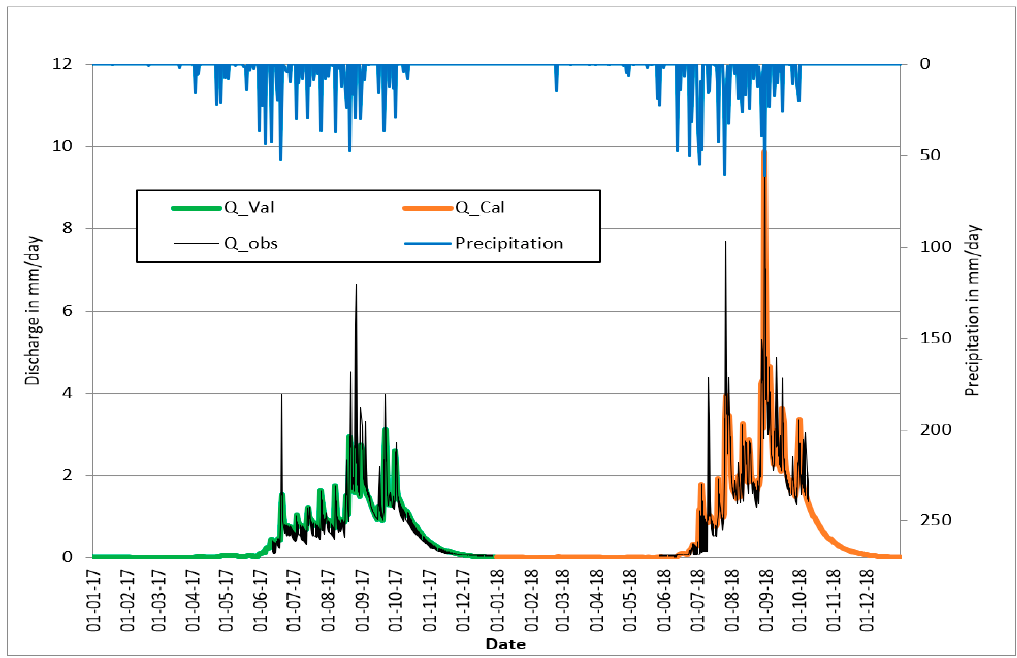
Figure 6. Observed and simulated discharges produced by the HBV model (Q_Val, Q_Cal, and Q_obs corresponding to the validation discharge, the calibration discharge, and the observed discharge, respectively).